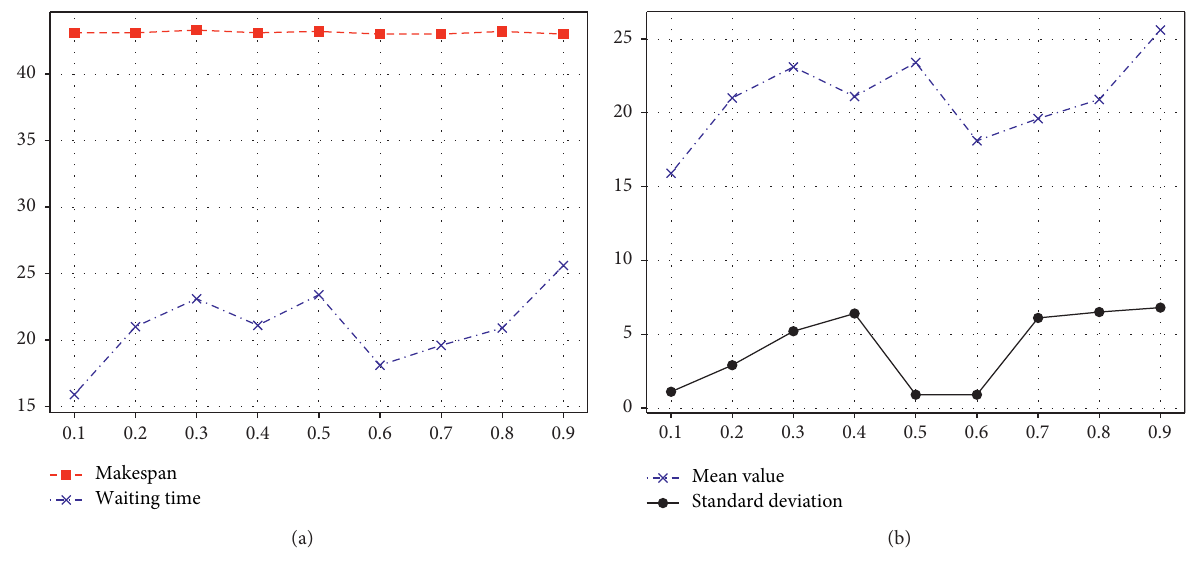
Figure 11: The results of weight